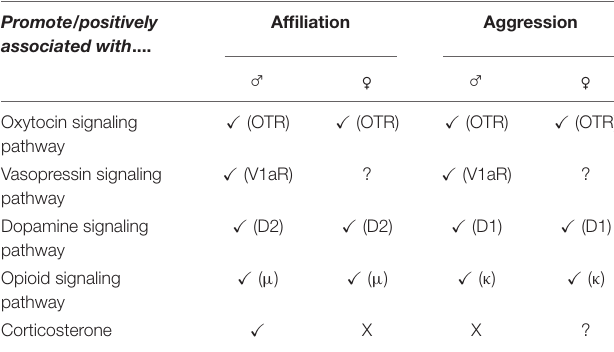
Check marks denote pathways that promote or are positively associated with affiliation or aggression. Parentheses indicate implicated receptor subtypes. X’s indicate pathways that do not promote affiliation or aggression, either by having no effect or by instead reducing the behavior. Question marks denote pathways that have not yet been